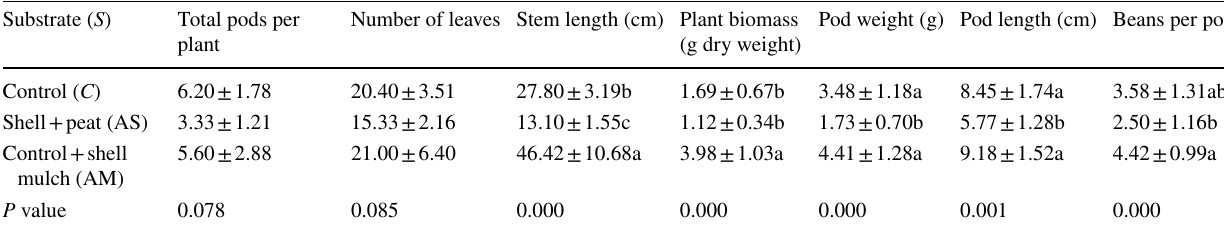
Table 1 Effect of the substrate on green bean plant and pod parameters 60 days after sowing